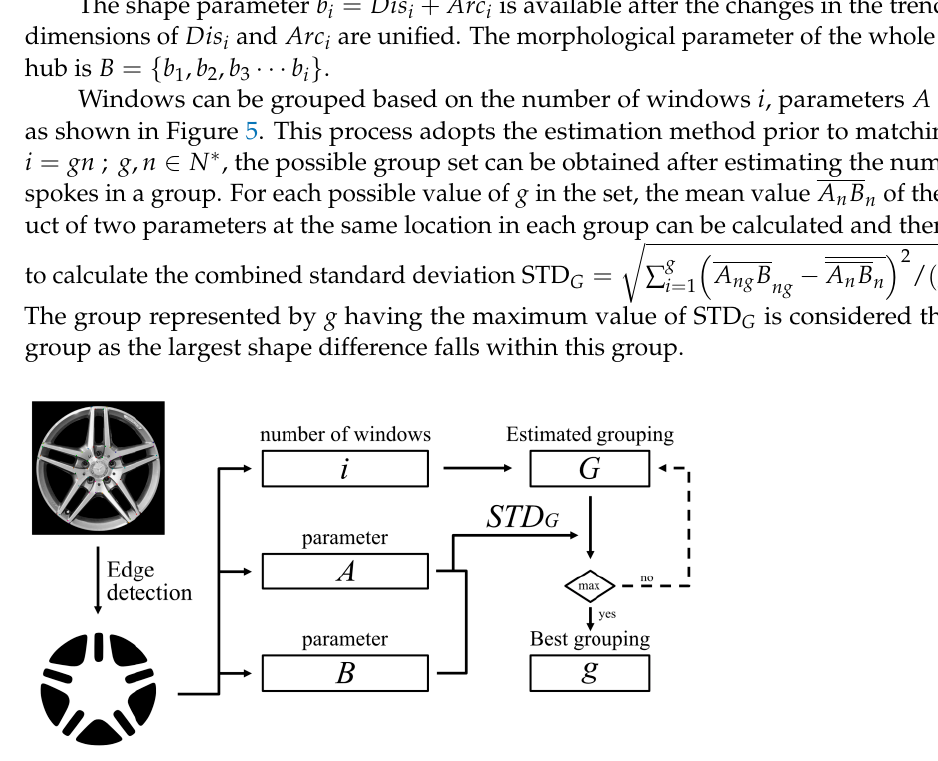
Figure 5. Feature grouping process. Based on the number of windows i , parameters A and B . By evaluating the STD G under all the expected groupings, the window difference within the group corresponding to its maximum value is the largest, indicating that the individual spokes within this group are least similar to each other and can be classified into a feature group.